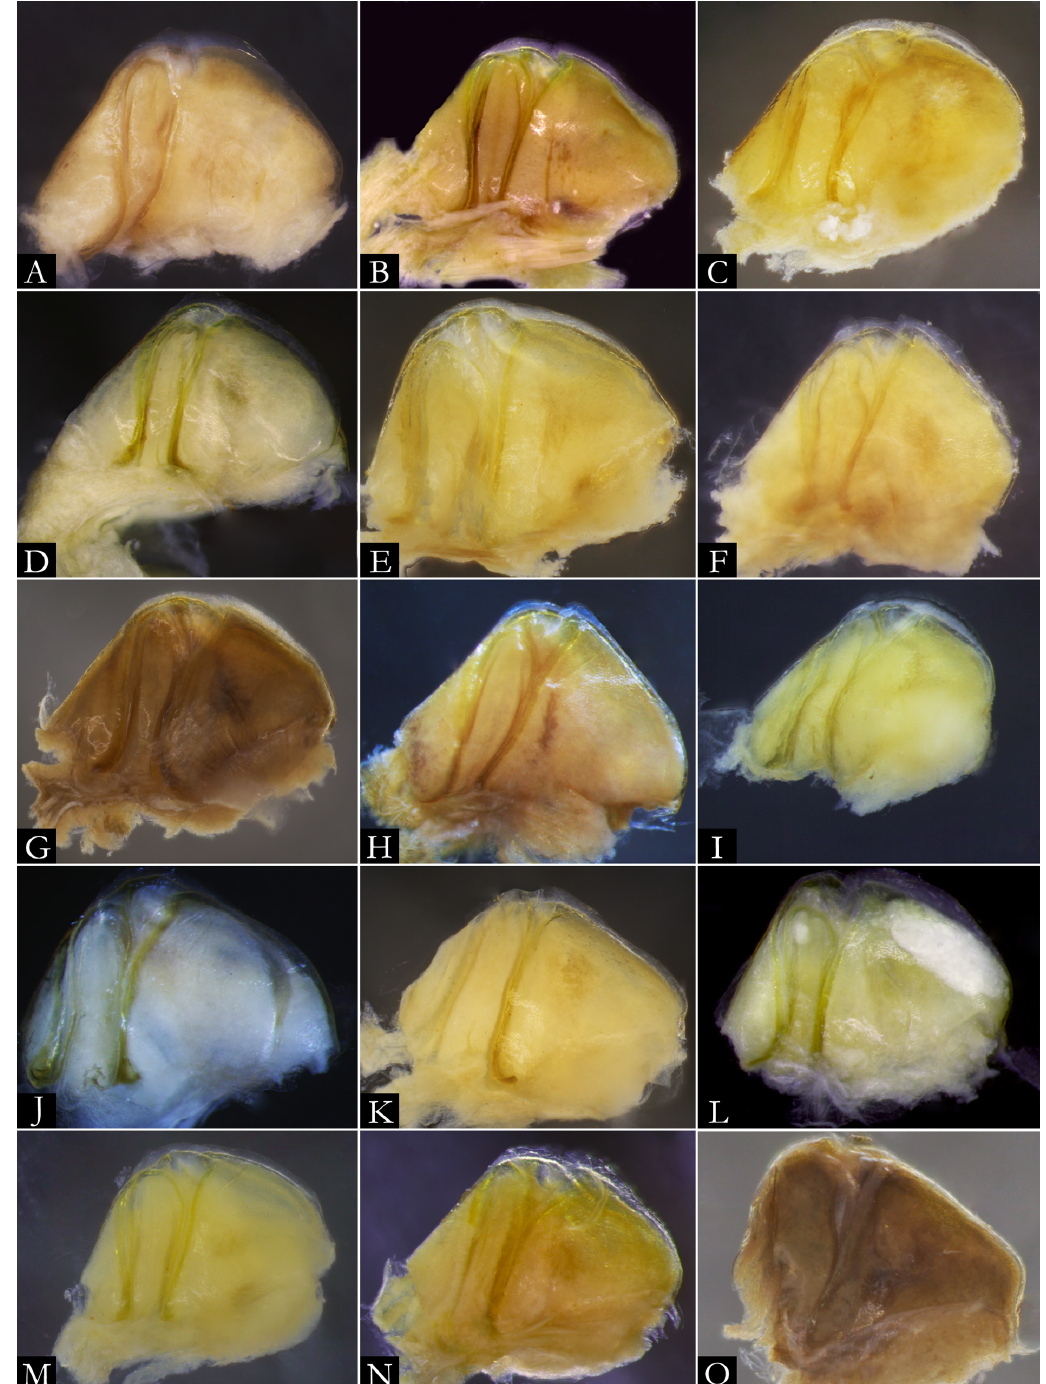
Fig. 178. Stereoscopic images of left vulva of species of Pseudonannolene Silvestri, 1895, in oral